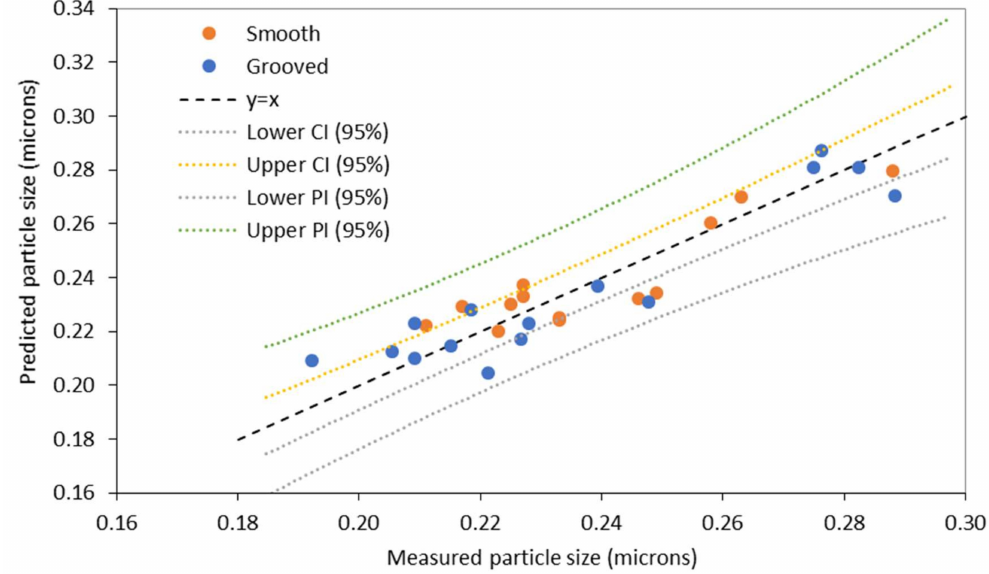
Figure 6. Comparison between predicted particle size and experimental particle size for smooth and grooved discs using Rossby number ( Ro